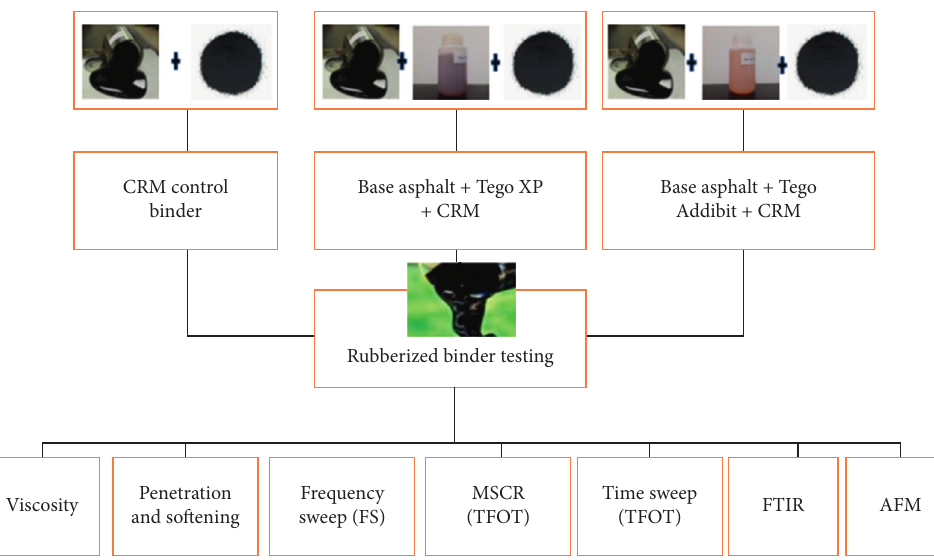
Figure 4: Experimental design flowchart of procedures utilized